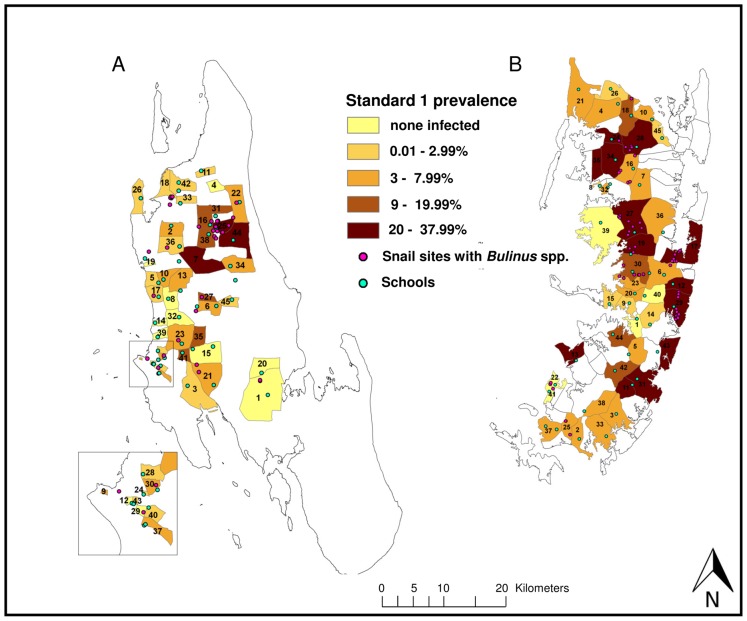

S. haematobium prevalence in first-year school children in 45 study shehias in Unguja (A) and Pemba (B).Map indicating the S. haematobium prevalence in first-year school children in the 45 study shehias in Unguja (A) and Pemba (B) at the baseline survey conducted in January-March 2012, surveyed schools in all 45 study shehias per island and sites in the 15 snail control shehias per island, where Bulinus spp. snails were found. Shehias in Unguja and their assigned intervention: Biannual mass drug administration with praziquantel: 1 = Cheju, 2 = Donge Mnyimbi, 3 = Fuoni Kibondeni, 4 = Gamba, 5 = Kama, 6 = Kiboje Mkwajuni, 7 = Kitope, 8 = Mbuzini, 9 = Mchangani, 10 = Mfenesini, 11 = Mkwajuni, 12 = Muungano, 13 = Mwakaje, 14 = Mwanyanya, 15 = Ubago; biannual mass drug administration with praziquantel plus snail control: 16 = Bandamaji, 17 = Chuini, 18 = Donge Mchangani, 19 = Fujoni, 20 = Jendele, 21 = Jumbi, 22 = Kandwi, 23 = Kianga, 24 = Kilimahewa Juu, 25 = Kinyasini, 26 = Mafufuni, 27 = Miwani, 28 = Mtopepo, 29 = Nyerere, 30 = Welezo; biannual mass drug administration with praziquantel plus behaviour change interventions: 31 = Chaani Kubwa, 32 = Dole, 33 = Donge Mtambile, 34 = Kilombero, 35 = Koani, 36 = Mahonda, 37 = Melinne, 38 = Mgambo, 39 = Mtoni, 40 = Mwanakwerekwe, 41 = Mwera, 42 = Pale, 43 = Sebleni, 44 = Upenja, 45 = Uzini. Shehias in Pemba and their assigned intervention: Biannual mass drug administration with praziquantel: 1 = Chanjaani, 2 = Kangani, 3 = Kiwani, 4 = Konde, 5 = Matale, 6 = Ole, 7 = Pandani, 8 = Selemu, 9 = Tibirinzi, 10 = Tumbe, 11 = Ukutini, 12 = Uwandani, 13 = Wambaa, 14 = Wawi, 15 = Wesha; Biannual mass drug administration with praziquantel plus snail control: 16 = Finya,17 = Kangagani, 18 = Kinowe, 19 = Kisiwani, 20 = Kwale, 21 = Makangale, 22 = Makombeni, 23 = Mbuzini, 24 = Mgogoni, 25 = Mkanyageni, 26 = Msuka, 27 = Piki, 28 = Shumba Viamboni, 29 = Vitongoji, 30 = Ziwani; biannual mass drug administration with praziquantel plus behaviour change interventions: 31 = Chambani, 32 = Jadida, 33 = Kengeja, 34 = Kinyasini, 35 = Kizimbani, 36 = Mchangamdogo, 37 = Michenzani, 38 = Mtambile, 39 = Mtambwe Kusini, 40 = Ng'ambwa, 41 = Ng'ombeni, 42 = Ngwachani, 43 = Pujini, 44 = Shungi, 45 = Sizini.